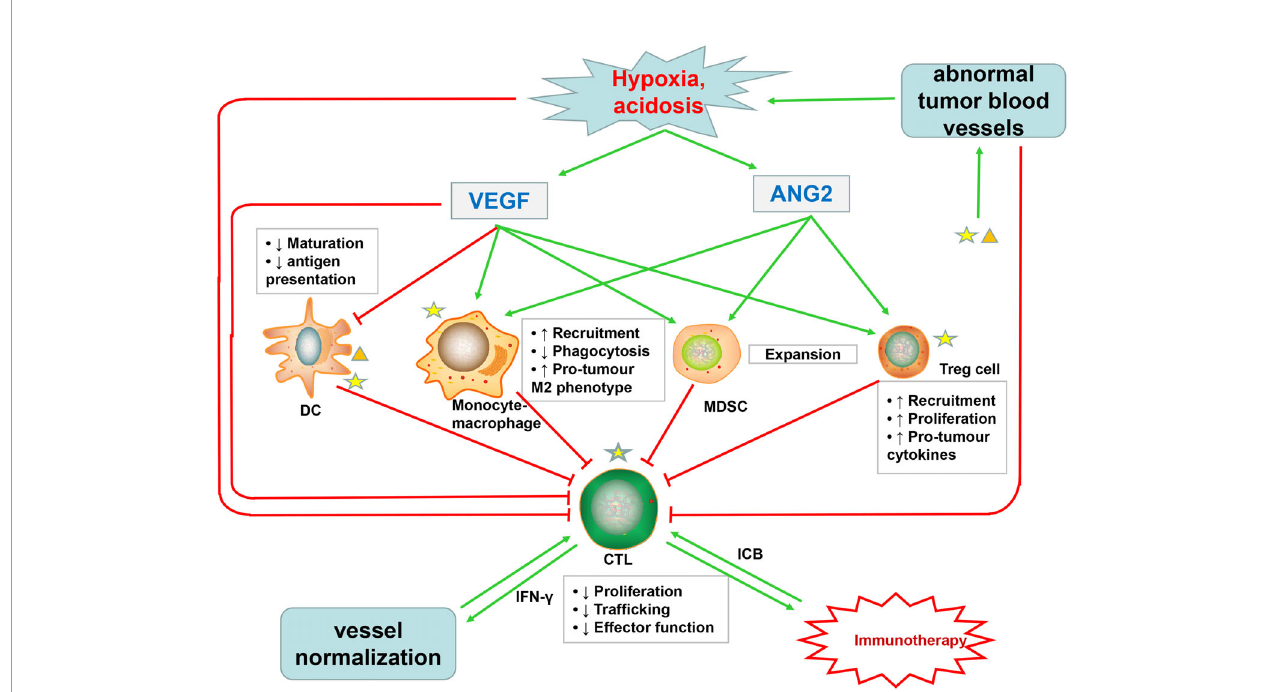
FIGURE 3 | Abnormal tumor blood vessels not only inhibit the in fi ltration of cytotoxic T lymphocytes (CTLs) but also promote the formation of hypoxic, acidic TME, which affects the function of CTLs and increases the accumulation of VEGF and Ang2. VEGF, in addition to directly impairing the function of CTLs, also inhibits the maturation and antigen presentation of DC, which are necessary for priming of CTLs. Ang2 restricts anticancer activity by modulating the function of monocytes. Both VEGF and Ang2 promote the recruitment of immunosuppressive cells such as Treg cells, MDSCs, and TAMs. These immunosuppressive cells suppress the activity of CTLs, which promote tumor vascular normalization through secreting IFN g . Immune cells, especially immunosuppressive cells, can produce excessive VEGF and Ang2, further promoting pathological angiogenesis. Immunotherapy with ICB can stimulate CTLs to produce IFN g , further inducing tumor vascular normalization. The normal tumor blood vessels can promote the in fi ltration of CTLs and enhance tumor immunotherapy, thus forming a virtuous